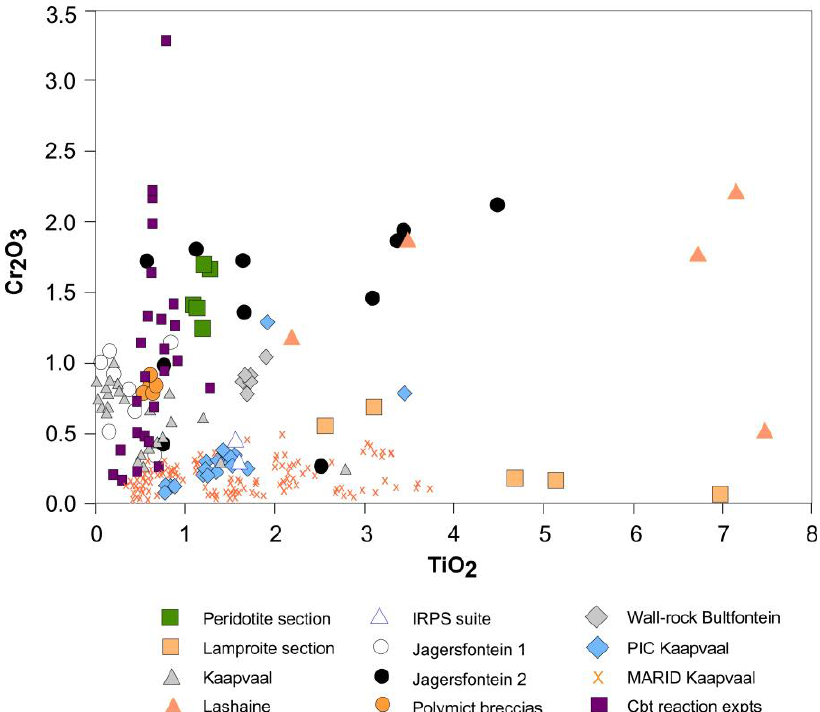
Figure 8. Comparison of phlogopites in peridotite (green squares) and lamproite (yellow squares) sections of the current experiments with phlogopites in natural mantle rocks. Data sources: Metasomatised Kaapvaal peridotites [4,50]; Lashaine peridotites [47]; Jagersfontein peridotites (1 = primary, 2 = secondary; [50]); IRPS suite [51]; Bultfontein peridotite close to vein, and polymict breccias [48]; MARID and PIC xenoliths [52]; experiments reacting carbonate-silicate melt with peridotite (“cbt reaction expts”; [53]).